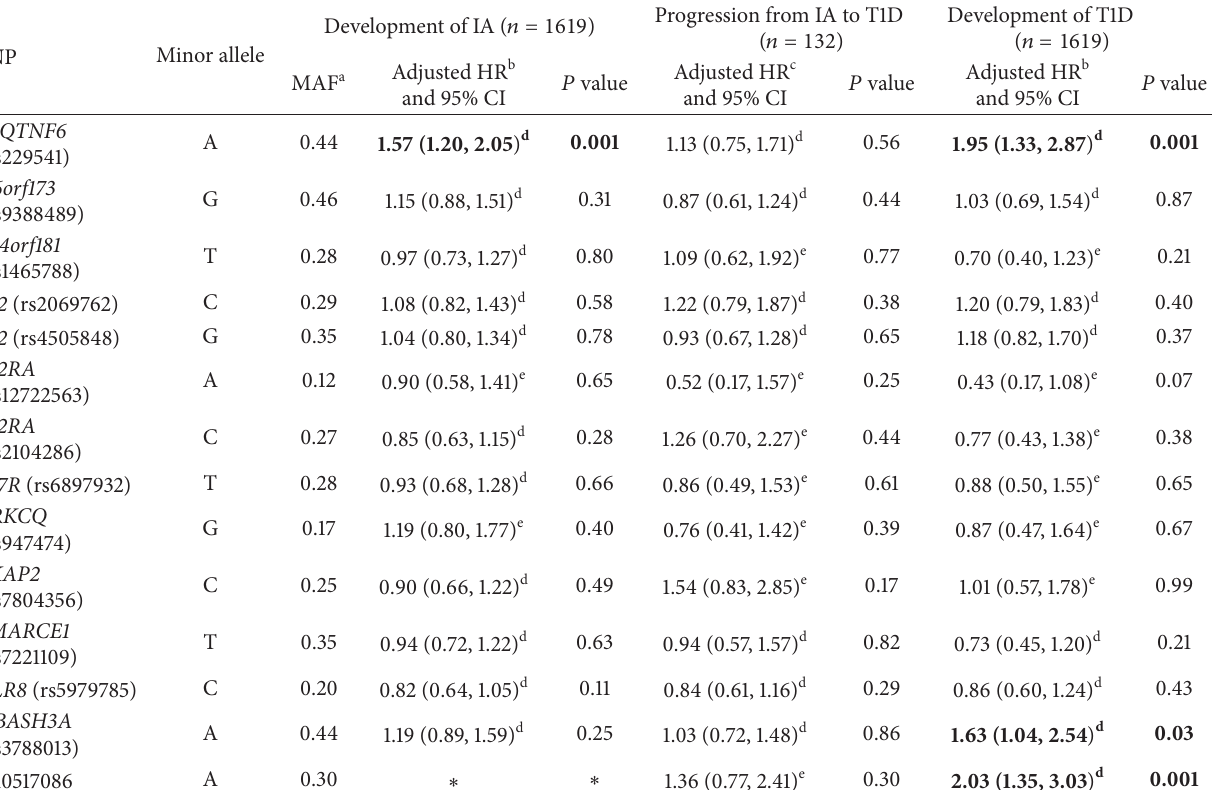
Table 2: Association between non-HLA T1D candidate SNPs and development of IA, progression from IA to T1D, and development of